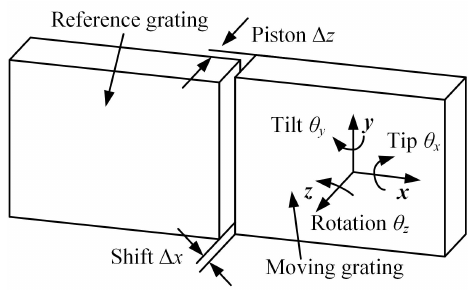
Figure 1. Schematic diagram of grating tiling.